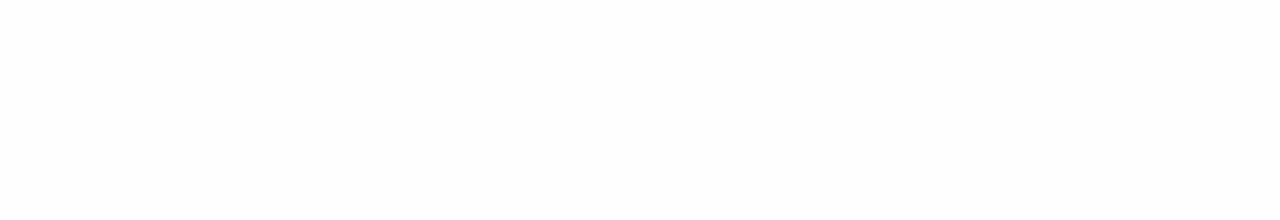
FIGURE 2 R/S analysis of the USD/GRD daily returns (a) Hurst exponent estimation through the R/S statistic plot (b) Cycle- length estimation through the V-statistic plot.